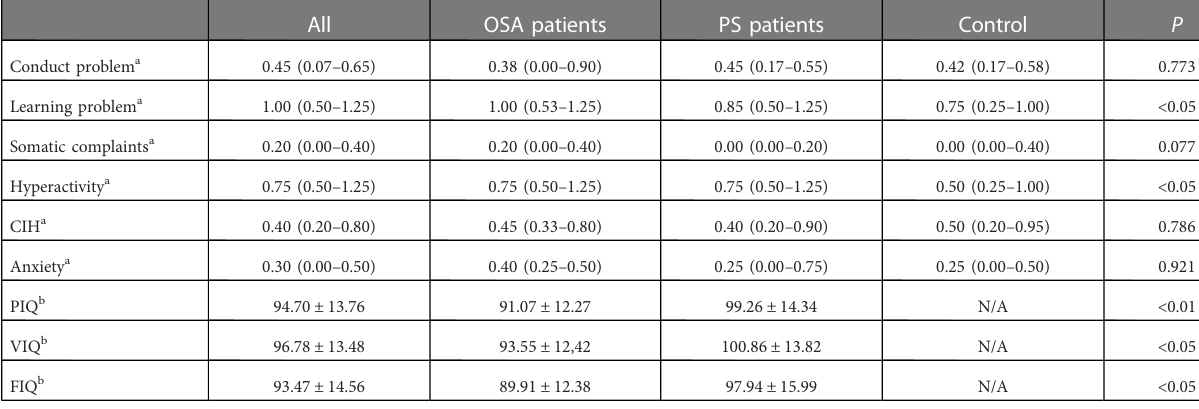
TABLE 3 Comparisons of cognitive and behavioral function tests between groups.